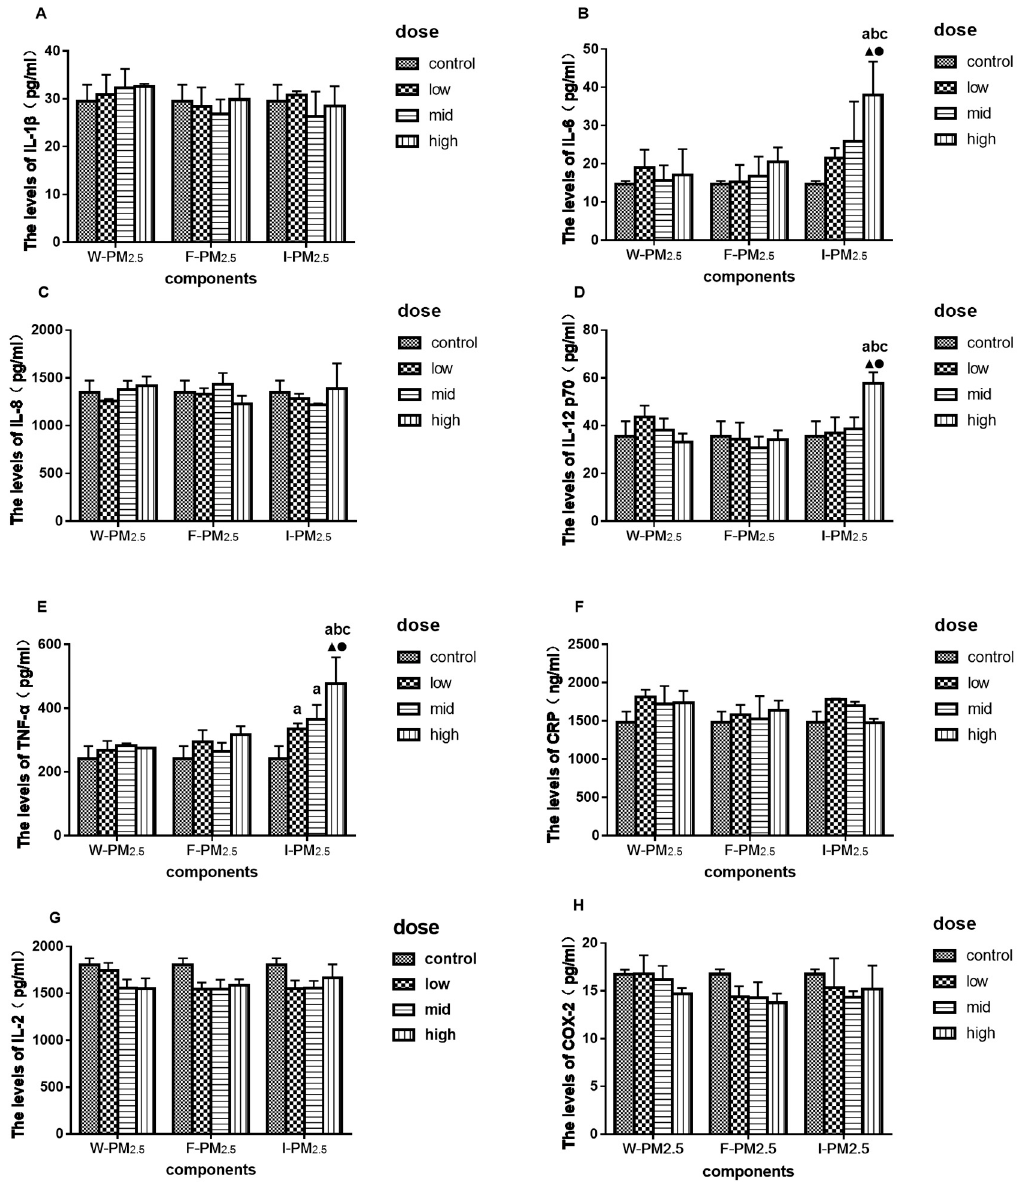
Figure 3. Effects of exposure to PM 2.5 on the levels of IL-1 β ( A ), IL-6 ( B ), IL-8 ( C ), IL-12 p70 ( D ), TNF- α ( E ), CRP ( F ), IL-2 ( G ), and COX-2 ( H ). Data are presented as means ± SD of three independent experiments. a p < 0.05 vs. control group; b p < 0.05 vs. low-dose group; c p < 0.05 vs. mid-dose group; ▲ p < 0.05 vs. W-PM 2.5 at the same dose; ● p < 0.05 vs. F-PM 2.5 at the same dose.